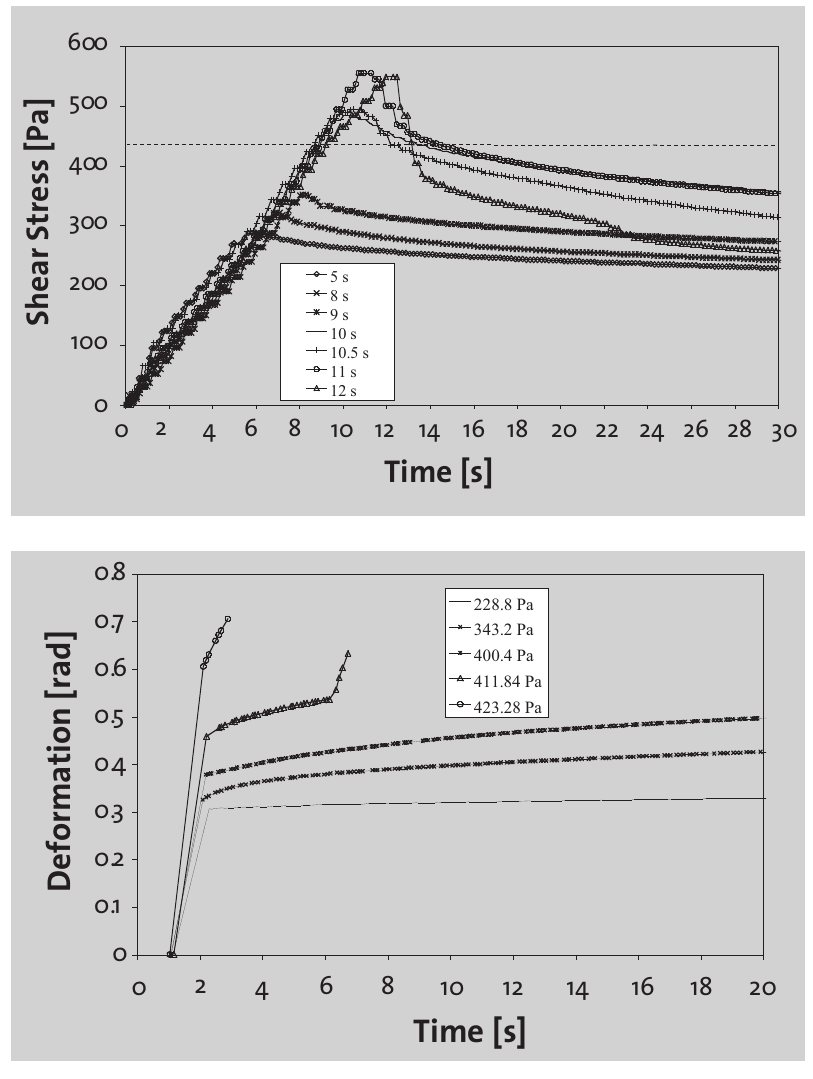
Figure 6 (above) : Yield stress determination of a 2.5 g/kg Kappa- carrageenan gel using maximum stress for different rotation times. Each curve was obtained using a fresh sample (VT 550 Haake rheometer). Figure 7 (below) : Yield stress determination of a 2.5g/kg Kappa- carrageenan gel using creep measurements. Each curve was obtained using a fresh sample (RS 150 Haake